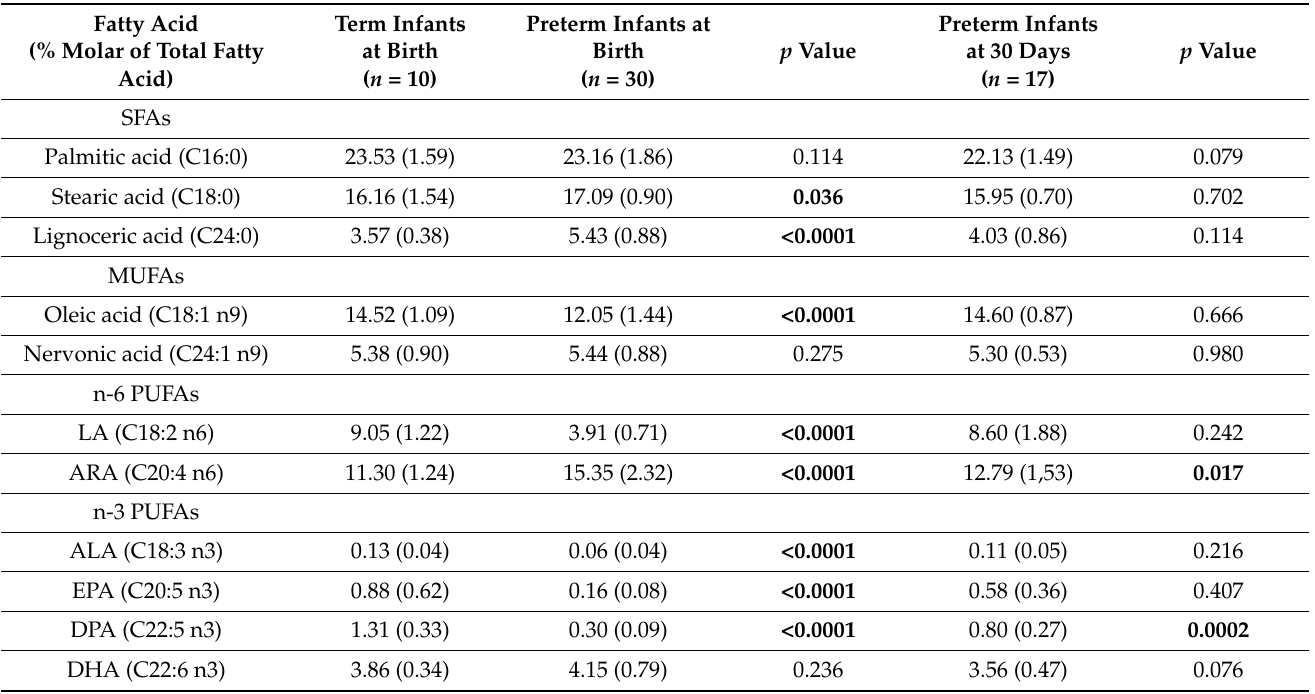
Table 3. Content of individual fatty acids of the main families in erythrocyte membranes at birth and at 30 days of life in preterm neonates as compared with infants born at